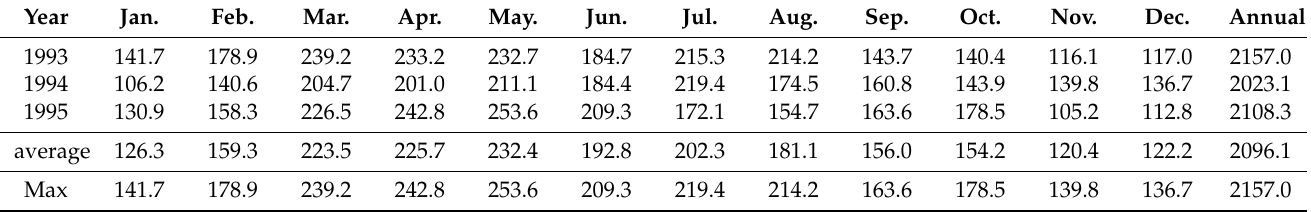
Table 6. Complete monthly evaporation records for the Zimapán reservoir, maximum evaporation sheet (mm).